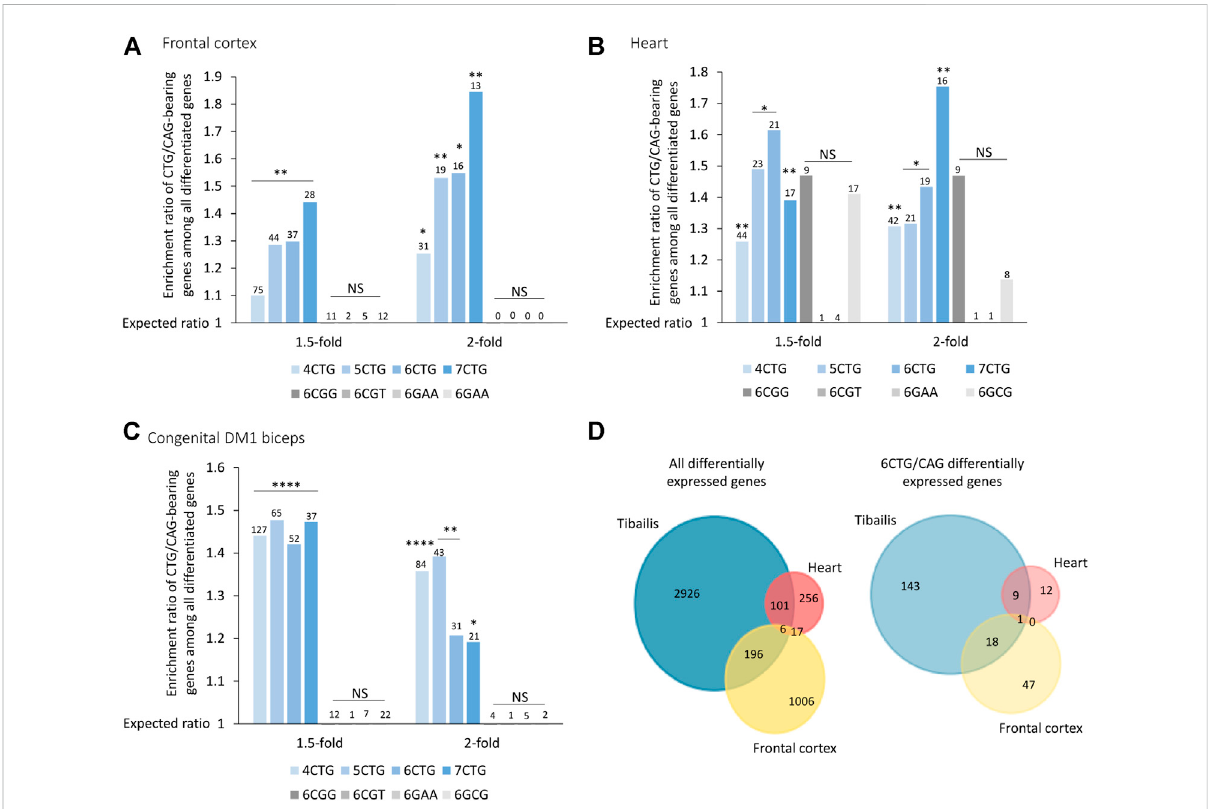
FIGURE 3 Genes bearing CTG/CAG-repeats are differentially expressed across frontal cortex (A) , heart (B), and congenital DM1 biceps (C) biopsies. Bar plotpresentsratioofgenesbearingCTG/CAG-repeatsthataredifferentiallyexpressedinDM1samplesdividedbytheexpectednumberderivedfrom theprevalenceofthosegenesintherespectivetissue.Differentfold-changethresholdsandlengthsofconsecutiveCTG/CAGrepeatsarepresented. Additional combinations of pathogenic repeats (6CGG, 6CGT, 6GAA, and 6GCG) are depicted in gray. The number of genes differentially expressed for each group is indicated above the corresponding bar. (D) Venn diagram showing overlap of all differentially expressed genes and only 6CTG/CAG-containing genes in 1,2 or three DM1 tissues. *0.05; **0.01;